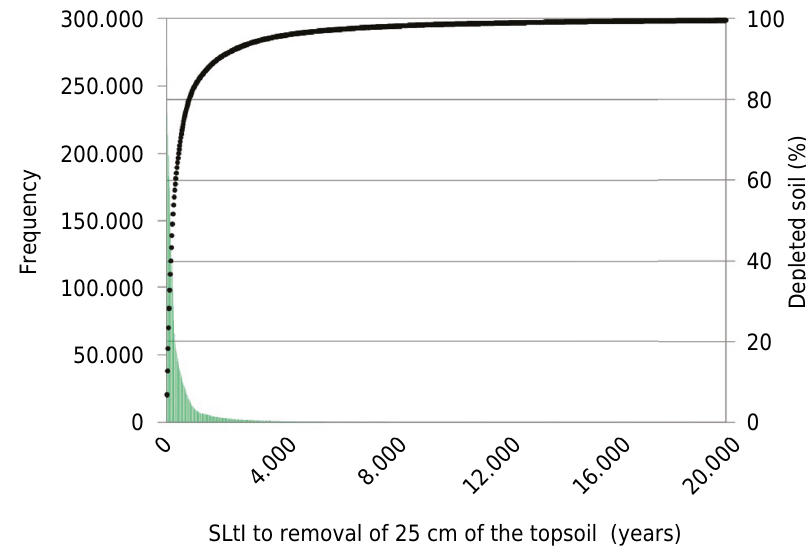
SLtI to removal of 25 cm of the topsoil Figure 9. The Soil Lifetime Index (SLtI) to removal of 0.25 m of the topsoil.